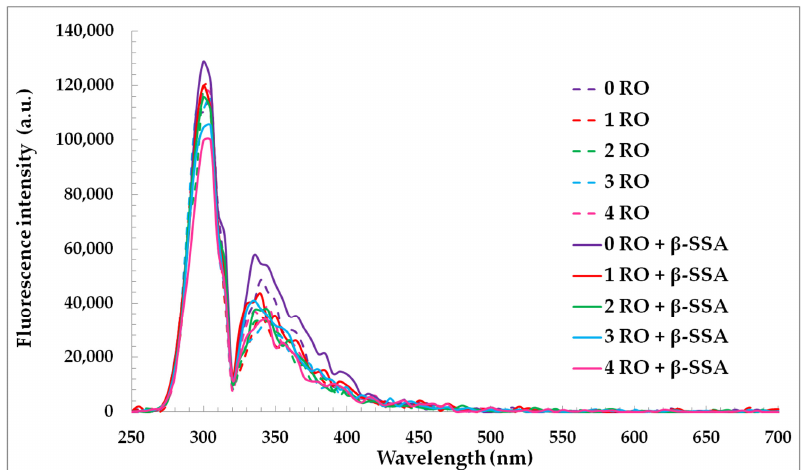
Figure 3. Synchronous fluorescence spectra of refined rapeseed oils without and with β -sitosteryl sinapate diluted in n -hexane (c = 1%) and recorded at ∆ λ = 30 nm after storage at accelerated conditions. Figure 4